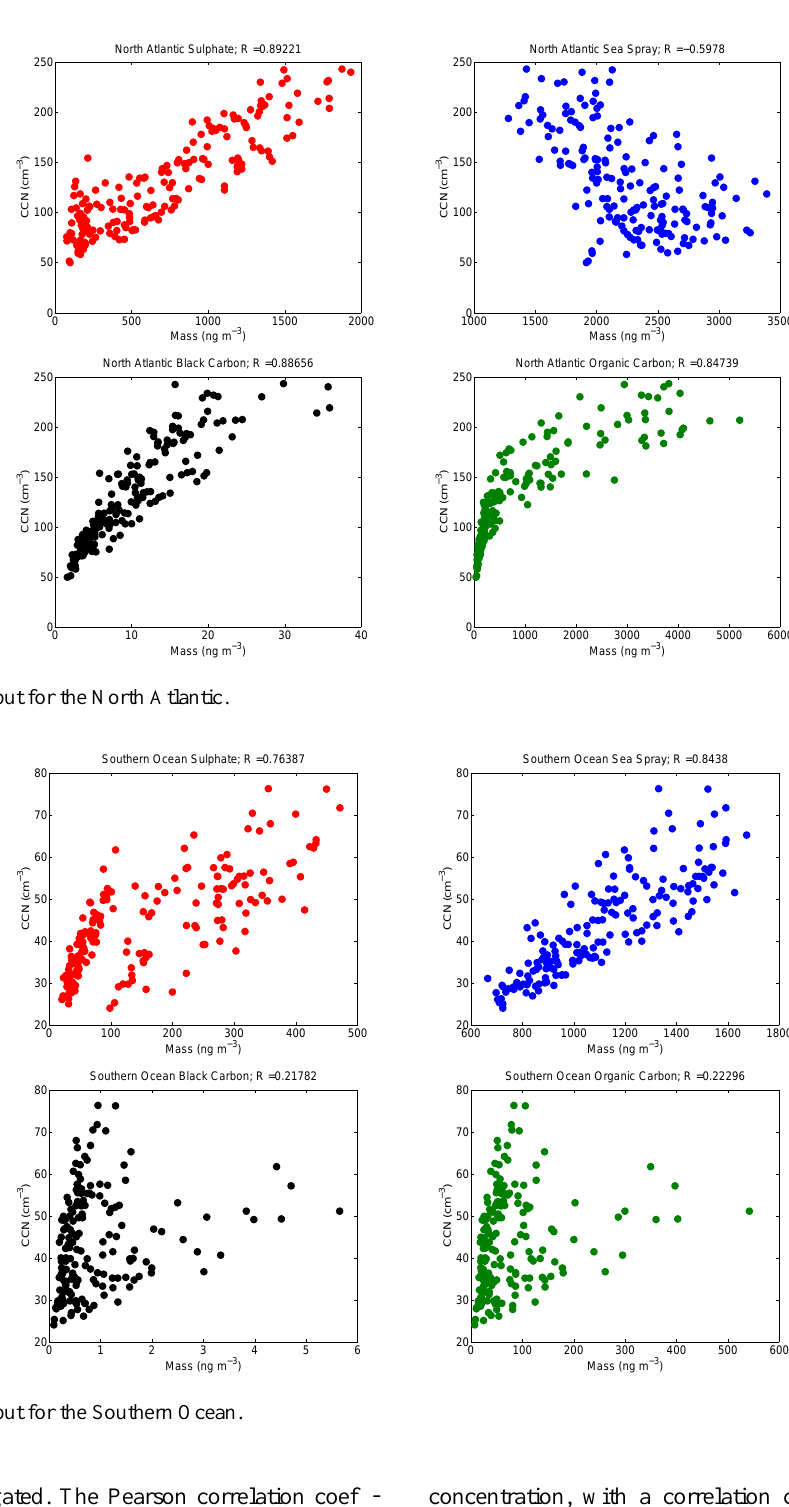
regions being investigated. The Pearson correlation coeffi- cients for the data sets are given in Table 1. Over the Northern Equatorial Pacific, there is a moderate correlation between CCN concentrations and sulfate (0.55), black carbon (0.54), and organic carbon (0.45). Sea spray mass, on the other hand, behaves independently of CCN